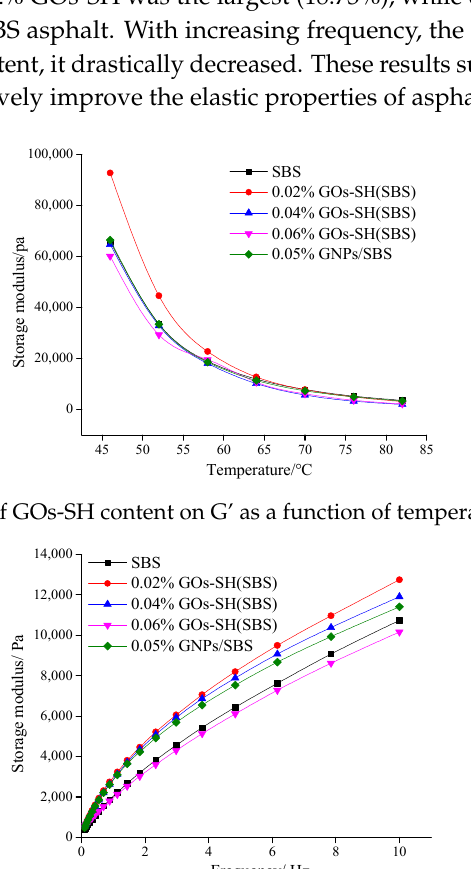
Figure 3. Tests results of modified asphalt with different GOs-SH content.